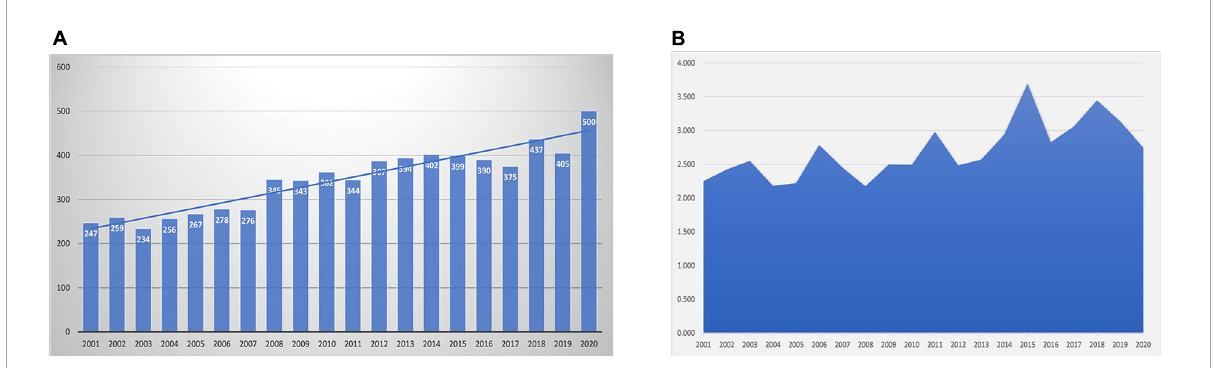
FIGURE1 An overall view of publications in ventricular arrhythmia research field. Annual scientific publications of publications (A) and changing trends of annual average article citations (B) in the Web of Science Core Collection database, 2001-2020.